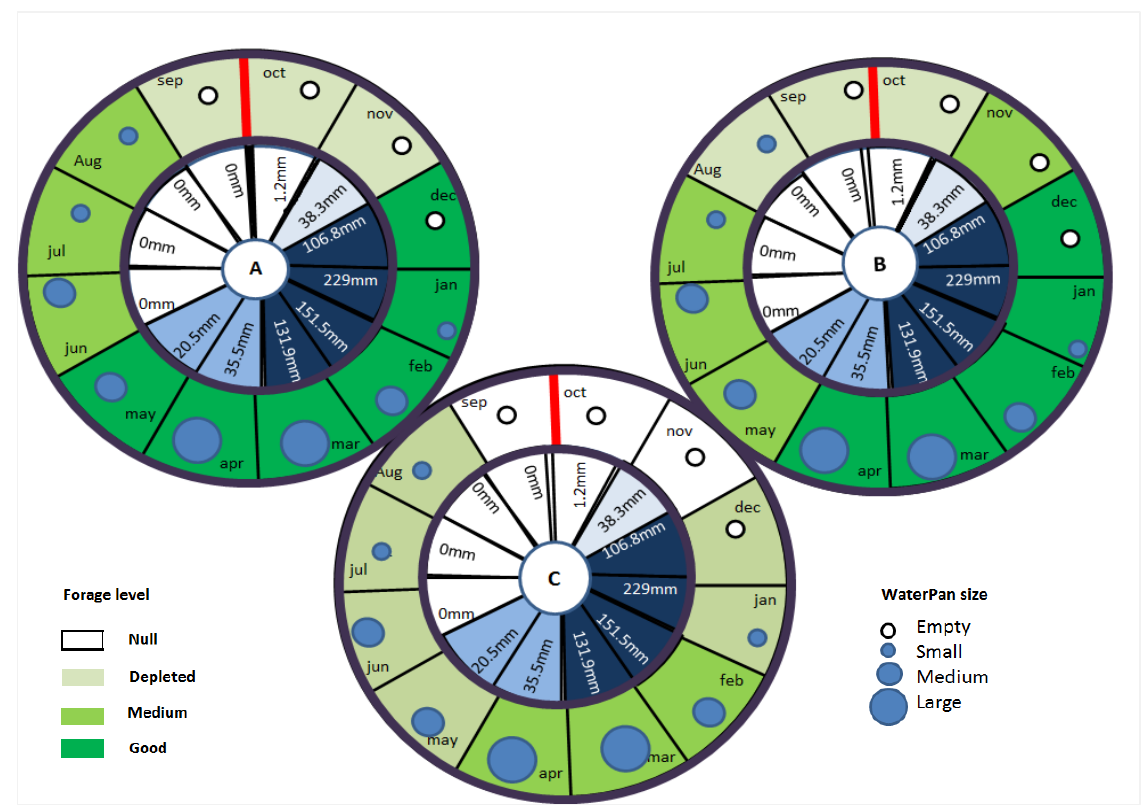
Figure 11. A representation of the tabulated function controlling the forage level of grazing areas and the size of water pans for the “Good Rain” year. The three diagrams represent the forage level at the end of each month in a given grazing area according to the number of cows grazing during the month. A: no cow grazing; B: between 1 and 10 cows; C: more than 10 cows. The circles in each month represent the size of water pans. Monthly rainfall is given on the inner